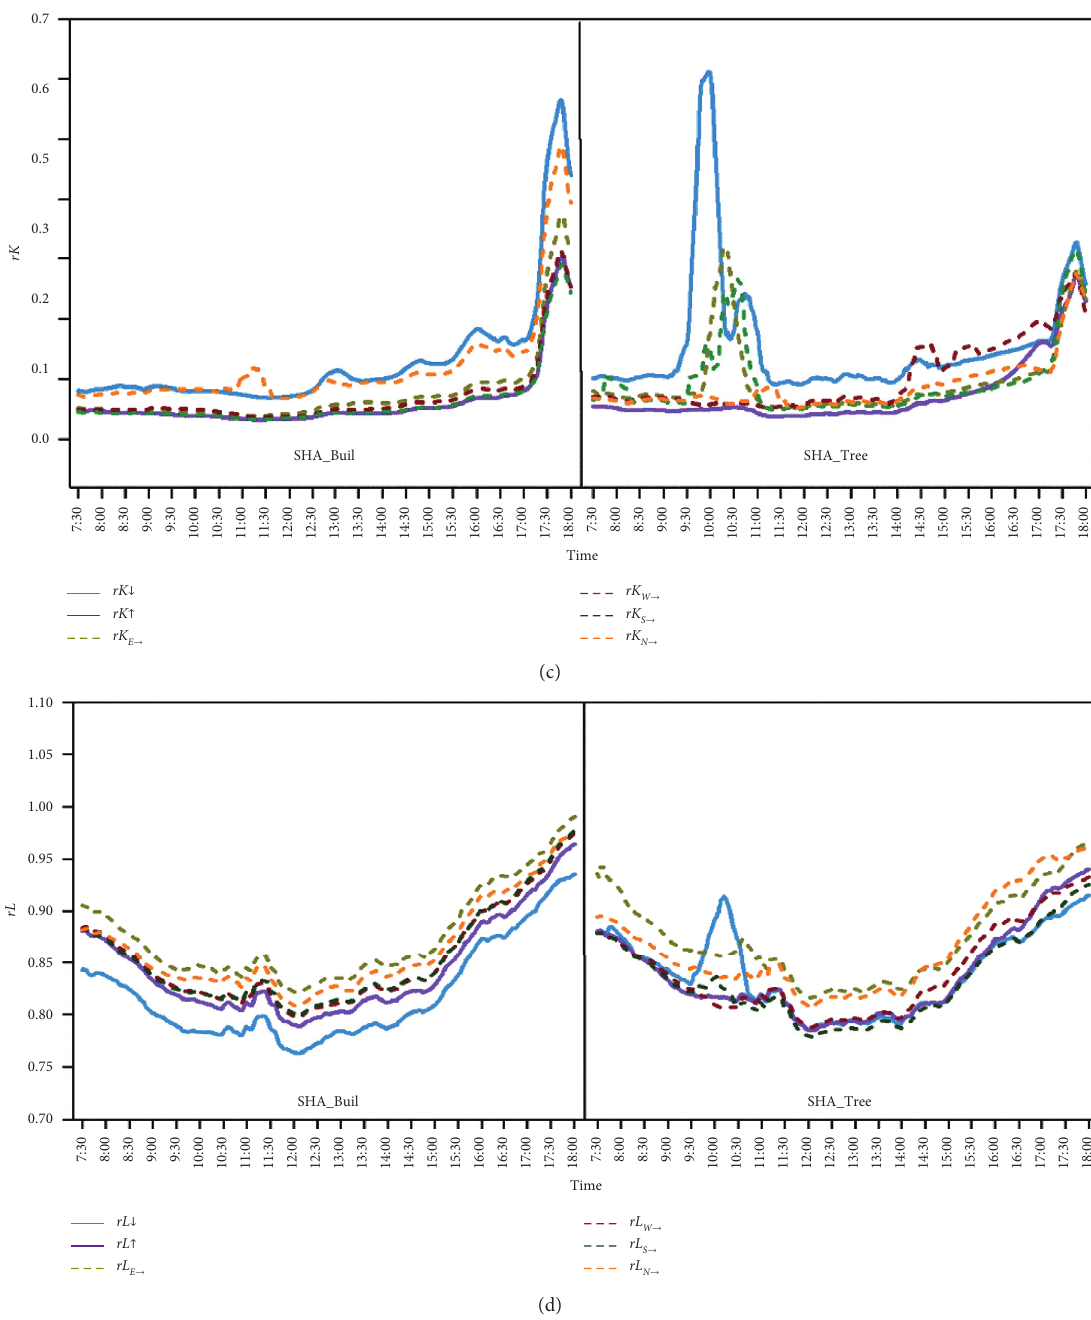
Figure 5: Diurnal patterns of K i , L i , rK i , and rL i on July 29, 2018: (a) temporal variation in short-wave radiant flux densities reaching the reference standing person at the measurement sites; (b) temporal variation in long-wave radiant flux densities reaching the reference standing person at the measurement sites; (c) standardized short-wave radiant components from six directions; (d) standardized long-wave radiant components from six